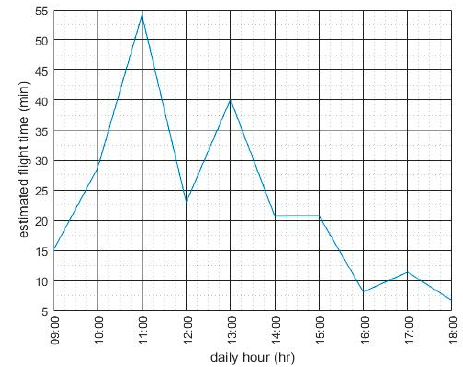
Figure 13. Estimated flight time for each time.